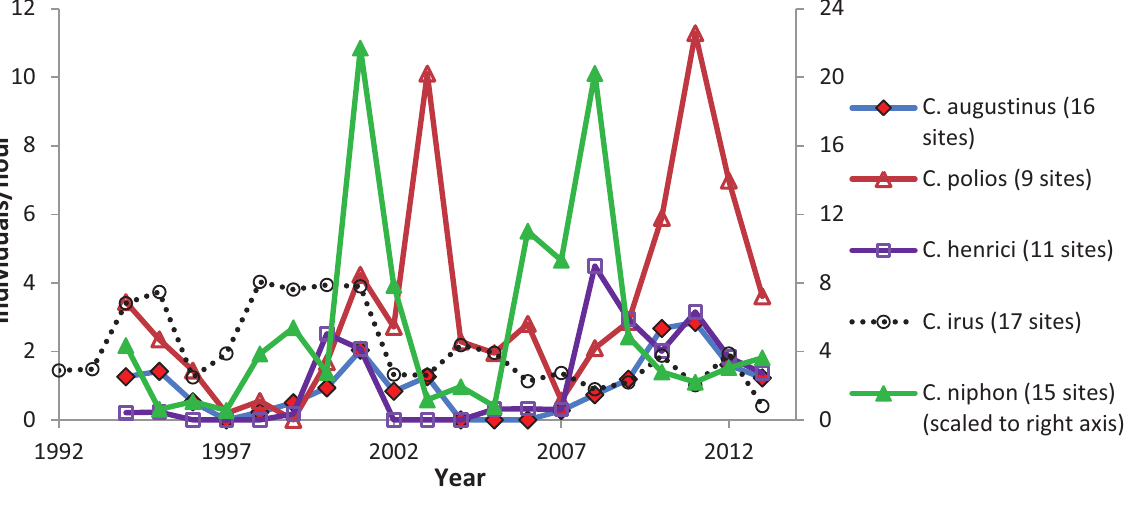
Figure 4. Mean C. augustinus abundance, for more reliable sites (recorded present >5 years out of 20) and less reliable sites (recorded present only 1 – 3 years out of 20).